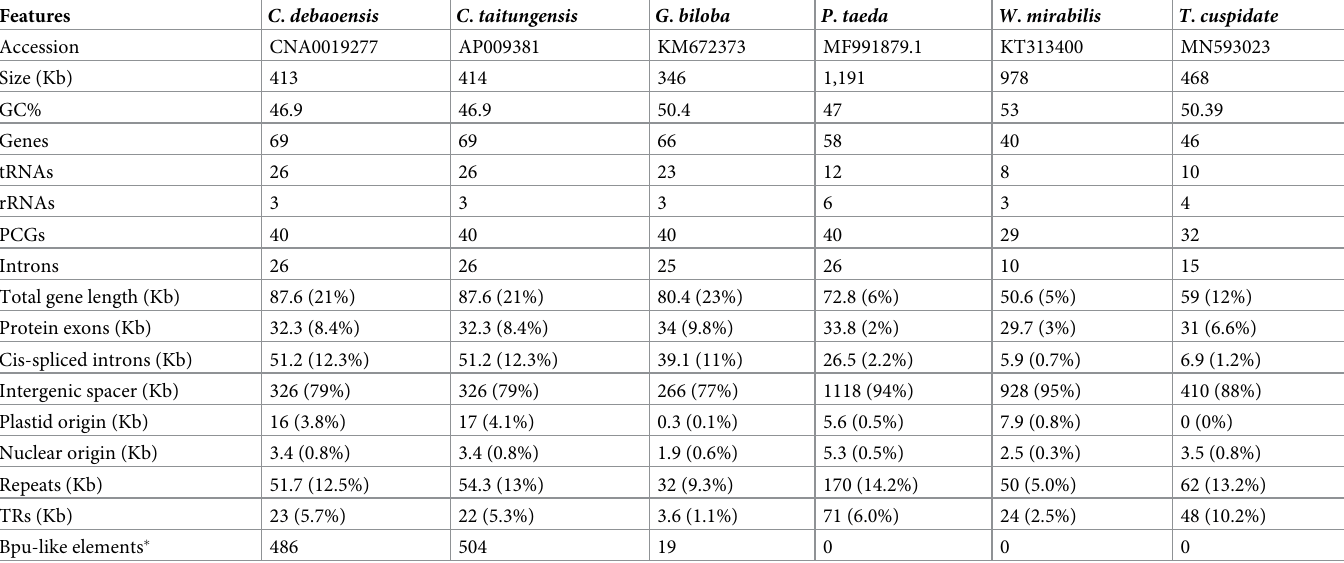
Table 1. General features of mitochondrial genomes of